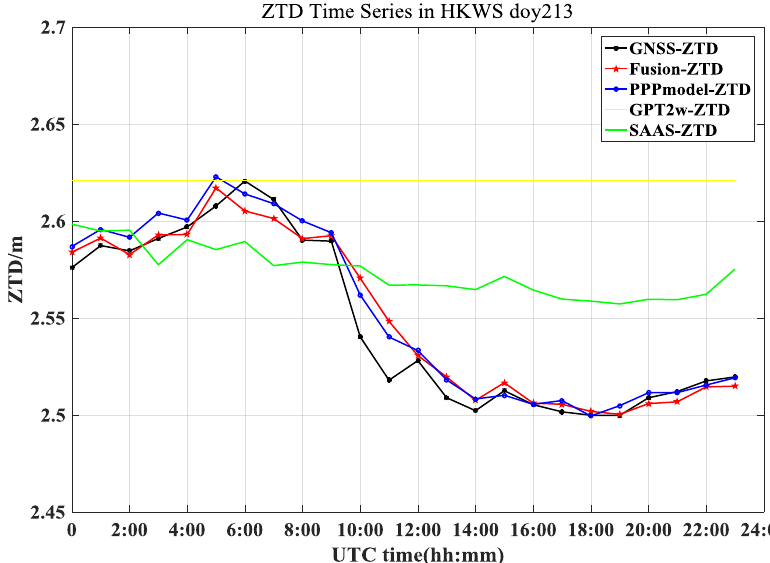
Figure 6. GNSS-derived and estimated ZTD by the kinds of models at station HKWS on DOY213. In Figure 7, the time series of the mean di ff erence are shown, as well as the corresponding standard deviations over the network for the fusion model, the PPP model, and other models for the quiet Remote Sens. 2019 , 4 , x FOR PEER REVIEW 14 of 20 troposphere period.